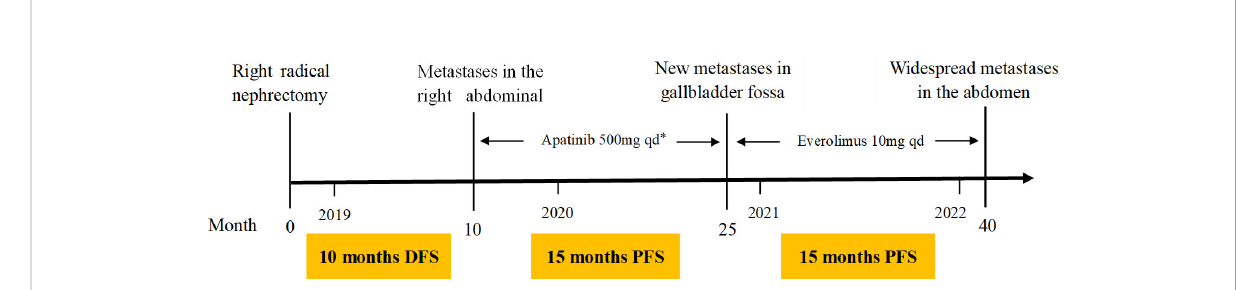
FIGURE 4 Patient treatment timeline. DFS, disease-free survival, PFS, progression-free survival. *Apatinib was started at 500 mg qd for 3 months and then increased to 750 mg qd for 10 days, but changed back to 500 mg qd due to the side effect at the high dosage (high blood pressure and nose